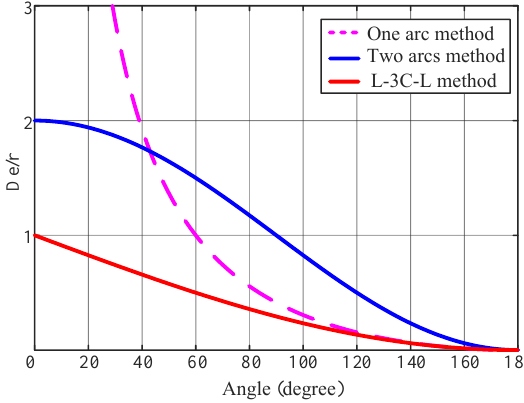
Figure 5. Path deviation comparison of the three smoothing